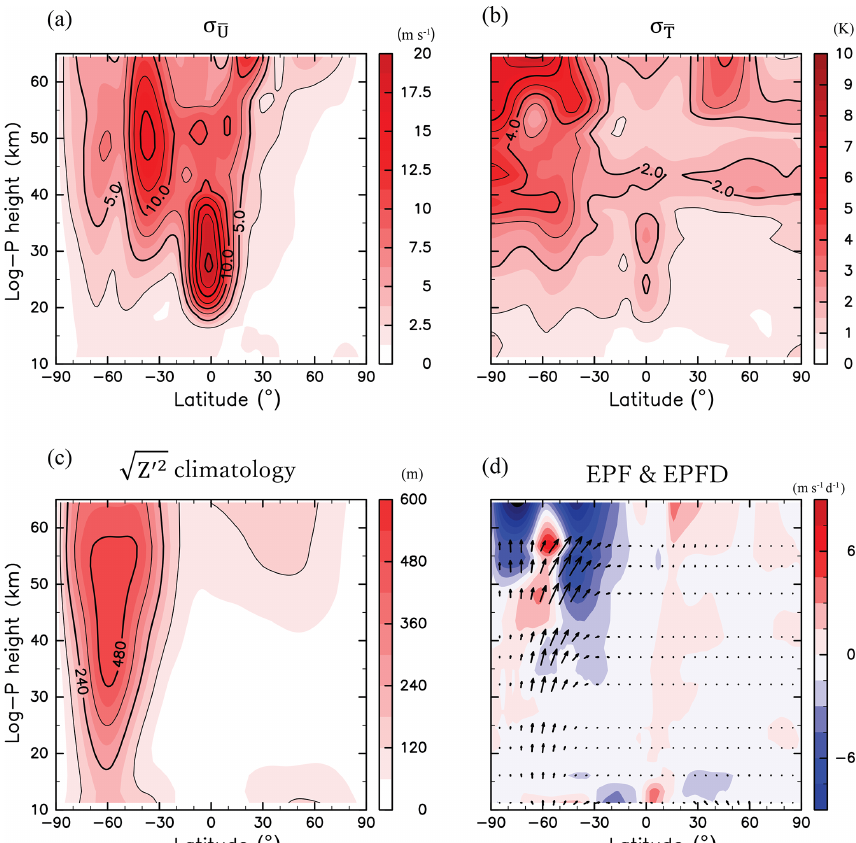
(cid:113) Z (cid:48) 2